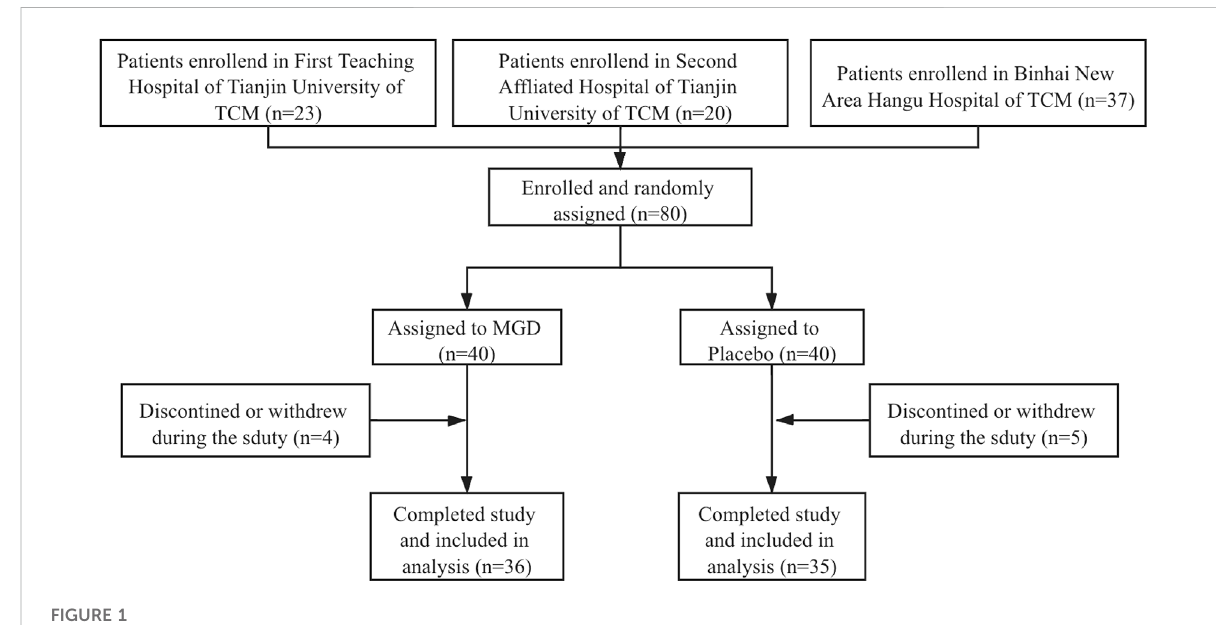
FIGURE 1 Flowchart of the